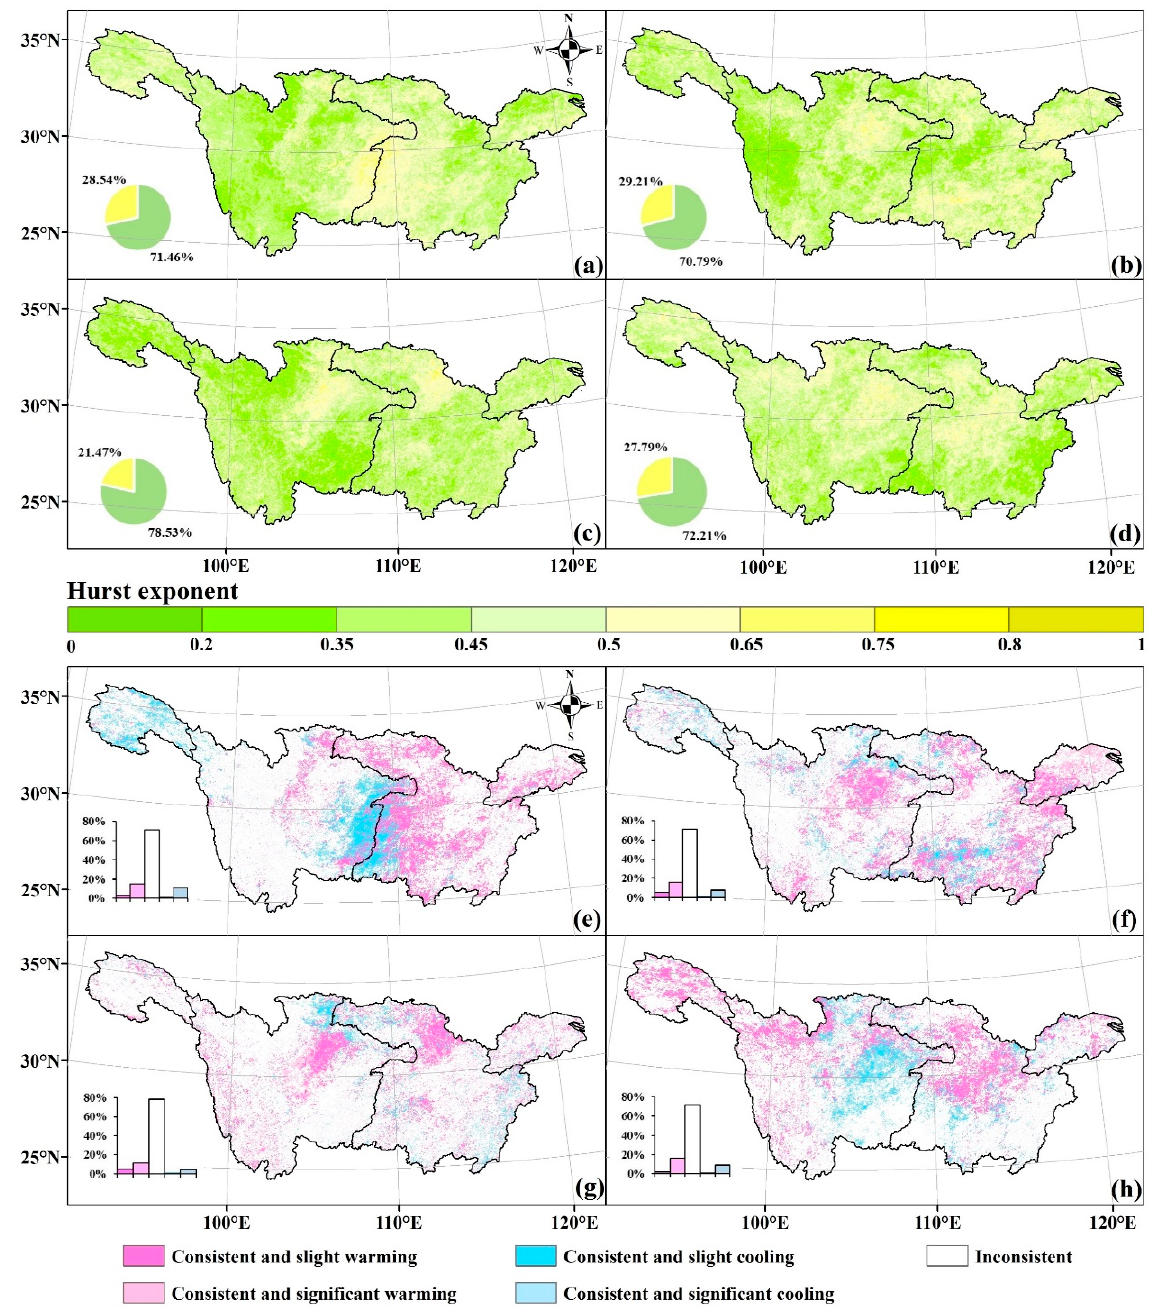
Figure 6. Spatial distribution of the Hurst exponent and consistency of the LST in winter ( a , e ); spring ( b , f ); summer ( c , g ); and autumn ( d , h ) from 2003 to 2021. The inset pie charts show the percentage of area with more than 0.5 and less than 0.5, respectively ( a – d ). In ( e – h ), the Hurst exponent and overall trend results of the LST are superimposed. The histogram shows the percentage of area with consistent and inconsistent change.